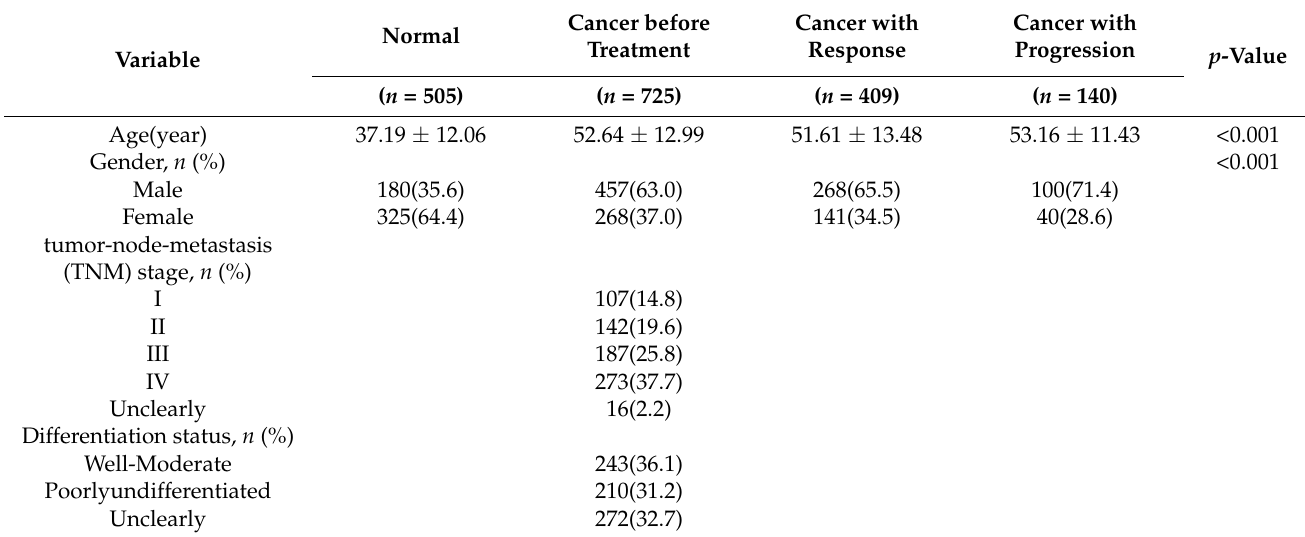
Table 1. Clinical characteristics of plasma samples from normal people and patients with malignant